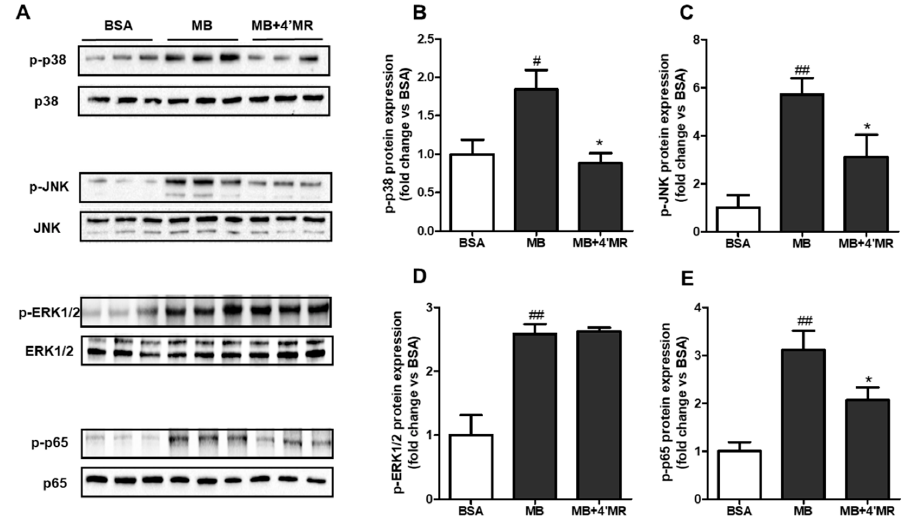
Figure 4. 4 ′ -Methoxyresveratrol down-regulated MAPKs/NF- κ B signaling pathway activation induced by MB in RAW264.7 macrophages. Cells were starved for 4 h and then treated with 200 µg/mL BSA or MB with or without 10 µM 4 ′ MR for 45 min. ( A ) Representative Western blotting images of phosphorylated and total p38 MAPK, JNK, ERK1/2 and p65. ( B – E ) Quantification of fold- change of: phosphorylated p38 MAPK ( B ); JNK ( C ); ERK1/2 ( D ); and p65 ( E ). All data are averages of triplicates from two separate experiments and shown as mean ± SD. # p < 0.05, ## p < 0.01 vs. BSA;